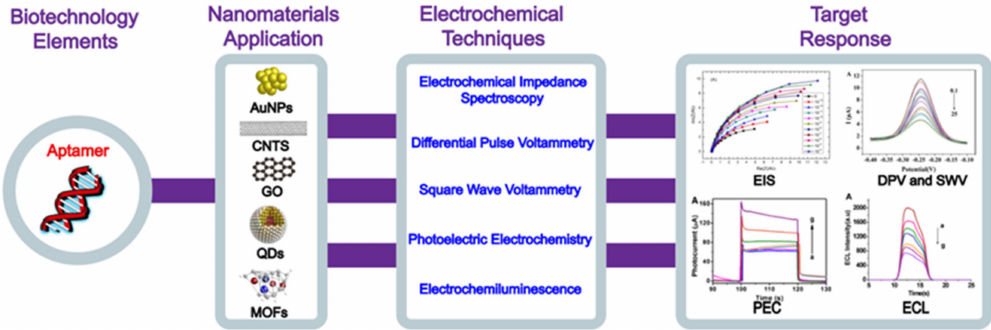
Figure 3. Schematic diagram of nanomaterial modified aptamer-based electrochemical